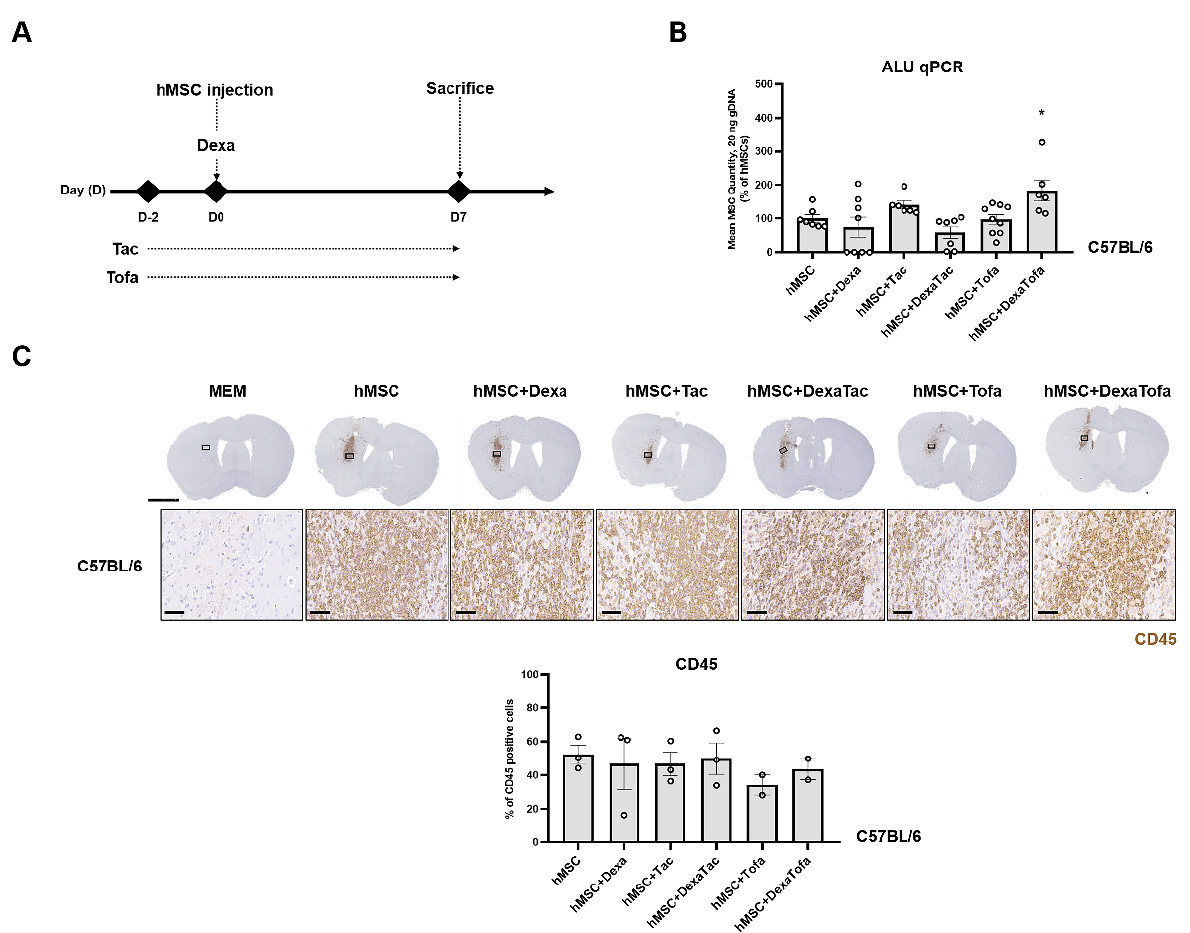
Figure 1. Examining the effects of various immunosuppressant regimens in WT mice transplanted with hMSCs. ( A ) Experimental Scheme. Dexamethasone (Dexa) was administered via the IV route at D0, right before and 4 h following hMSC transplantation. Both tacrolimus (Tac) and tofacitinib (Tofa) were administered orally starting at D-2 up to the sacrifice time point (D7). ( B ) Quantification of residual hMSCs in the WT mouse parenchyma carried out via ALU qPCR (hMSC: n = 7, hMSC+Dexa: n = 8, hMSC+Tac: n = 6, hMSC+DexaTac: n = 7, hMSC+Tofa: n = 9, hMSC+DexaTofa: n = 6). The highest number of residual hMSCs was observed from the hMSC + DexaTofa group. Statistical significance is defined as * p < 0.05 vs. hMSC; mean ± SEM (one-way ANOVA, Dunnett’s multiple comparison). ( C ) Representative images of CD45-positive leukocytes visualized as a dark brown precipitate (hMSC: n = 3, hMSC+Dexa: n = 3, hMSC+Tac: n = 3, hMSC+DexaTac: n = 3, hMSC+Tofa: n = 2, hMSC+DexaTofa: n = 2). Compared to hMSC transplantation alone, co-administration of immunosuppressants reduced leukocyte infiltration overall. Scale bars: whole brain =2 mm, magnified inset area (solid black box) = 60 µm.